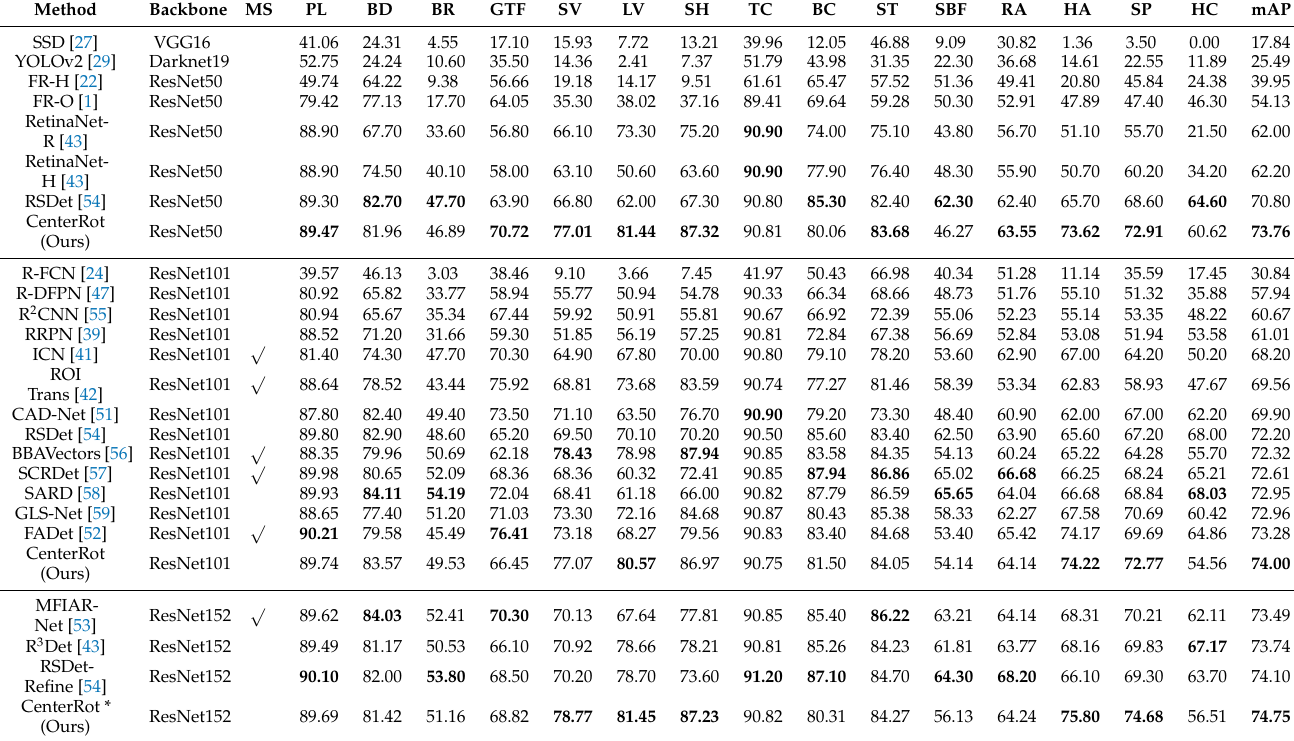
Table 2. State-of-the-Art comparison with other methods in the oriented object detection task in the DOTA test set. AP for each category and overall mAP on DOTA are provided (the best result is highlighted in bold), where MS denotes multi-scale training and testing and * denotes that larger deformable groups ( n = 16 in Deformable FPN) were used.